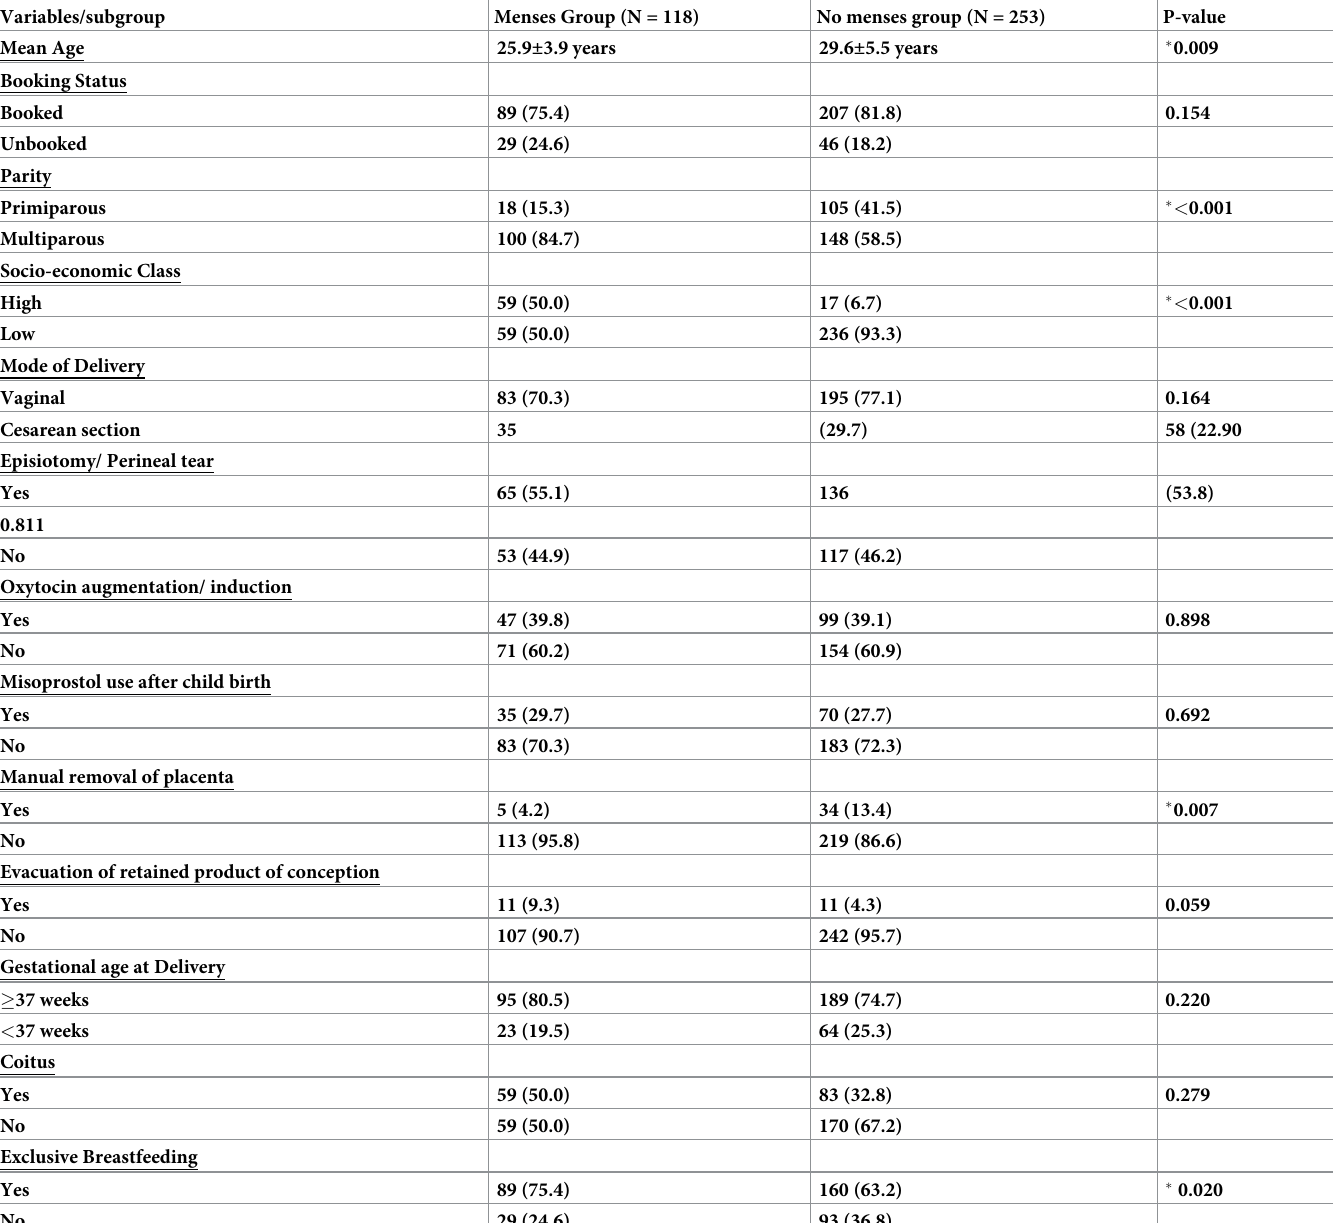
Table 2. Association between resumption of menses and respondents’ characteristics based on bivariate